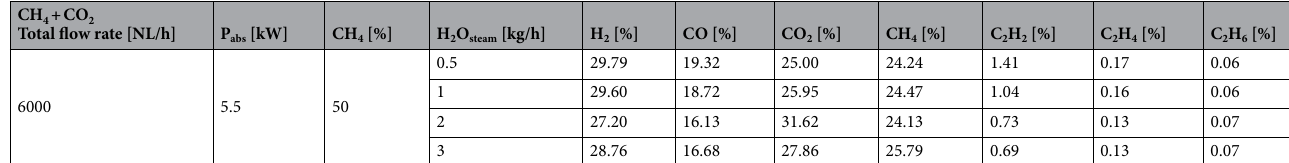
Table 2. Percentage of the major components of the output gas for various H 2 O steam consumption rate, absorbed microwave power